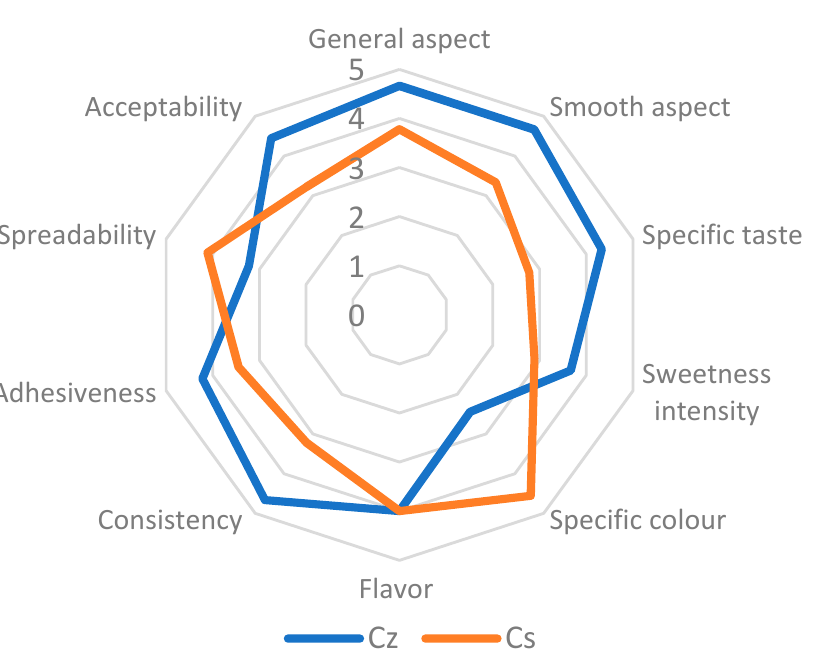
Figure 1. Sensorial analysis of sea buckthorn marmalades.